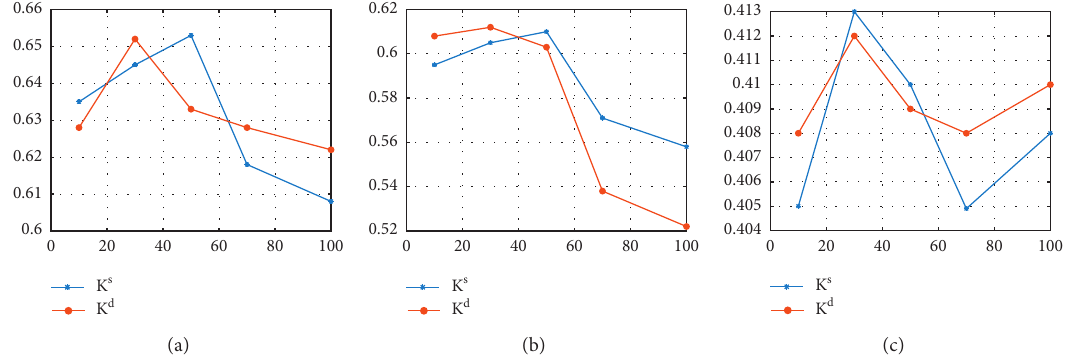
Figure 7: Effect of technical data sets K d and K s on model effects: (a) ROUGE-1, (b) ROUGE-L, and (c) BLEU-1.